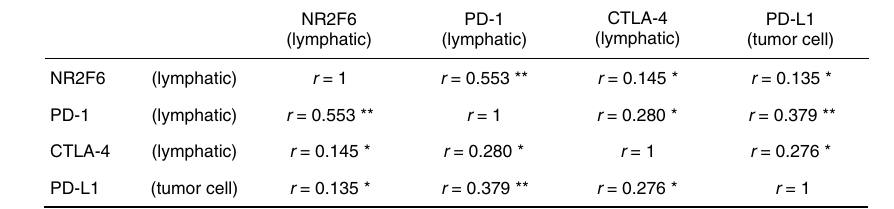
Fig. 6 IHC and qRT-PCR analyses of NSCLC tumor biopsies show upregulation of NR2F6 in TILs that may serve as marker of patient strati fi cation. a In patient tumor biopsies, there is signi fi cantly upregulated expression of NR2F6 in T cells (marked by arrows) in 54% of the cases (163 of 303 patients). b There is a signi fi cantly enhanced expression of NR2F6 in TILs from NSCLC tumor biopsies when compared to benign lung tissue ( n = 303 and n = 10, p < 0.001). c Signi fi cant higher NR2F6 expression levels ( p = 0.038, unpaired t -test) determined by qRT-PCR in CD3 + cells sorted from NSCLC tumor biopsies when compared to PBMC samples. d The number of NR2F6-expressing TILs was de fi ned as categorial variable: 0 = 0%, 1 = 1 – 25%, 2 = 26 – 50%, 3 = 51 – 75% and 4 = 76 – 100% NR2F6-positive TILs. The number of NR2F6-expressing TILs is not linked to clinical outcome as seen in overall survival of NSCLC patients from these de fi ned staining categories (0 – 4). e Multiplex IHC analyses showed that the increase in lymphatic NR2F6 expression strongly correlated with lymphatic PD-1 expression (Pearson correlation coef fi cient r = 0.553, p < 0.001). There was a positive correlation also between lymphatic NR2F6 and lymphatic CTLA-4 ( r = 0.145, p < 0.01) and tumor cell PD-L1 ( r = 0.135, p < 0.01) expression, Palpable tumors 10mm 2 with progressive growth for two successive weeks were recorded. 3-MCA tumor-induced cell lines . Sarcomas that had reached a size of 0.5cm 2 were excised aseptically. Tumors were cut into small pieces and treated with 1mg/ ml collagenase (type II; Sigma-Aldrich) and 40µg/ml DNase I at 37 °C for 1h, clumps were removed, and single cells were cultured in RPMI 1640 complete medium (10% FCS, 2mM L -glutamine, and 50U/ml penicillin/streptomycin). The cells were split with Trypsin/EDTA (T3924 Sigma) when they were con fl uent. All tumor cell lines were kept in culture for at least 2 months to minimize cellular contamination. Some sarcoma lines were injected s.c. into wild-type or Nr2f6 - de fi cient mice as indicated. Preparation of tumor-in fi ltrating cells . Mononuclear in fi ltrating cells were iso- lated from both subcutaneous and chemically induced tumors at the indicated time